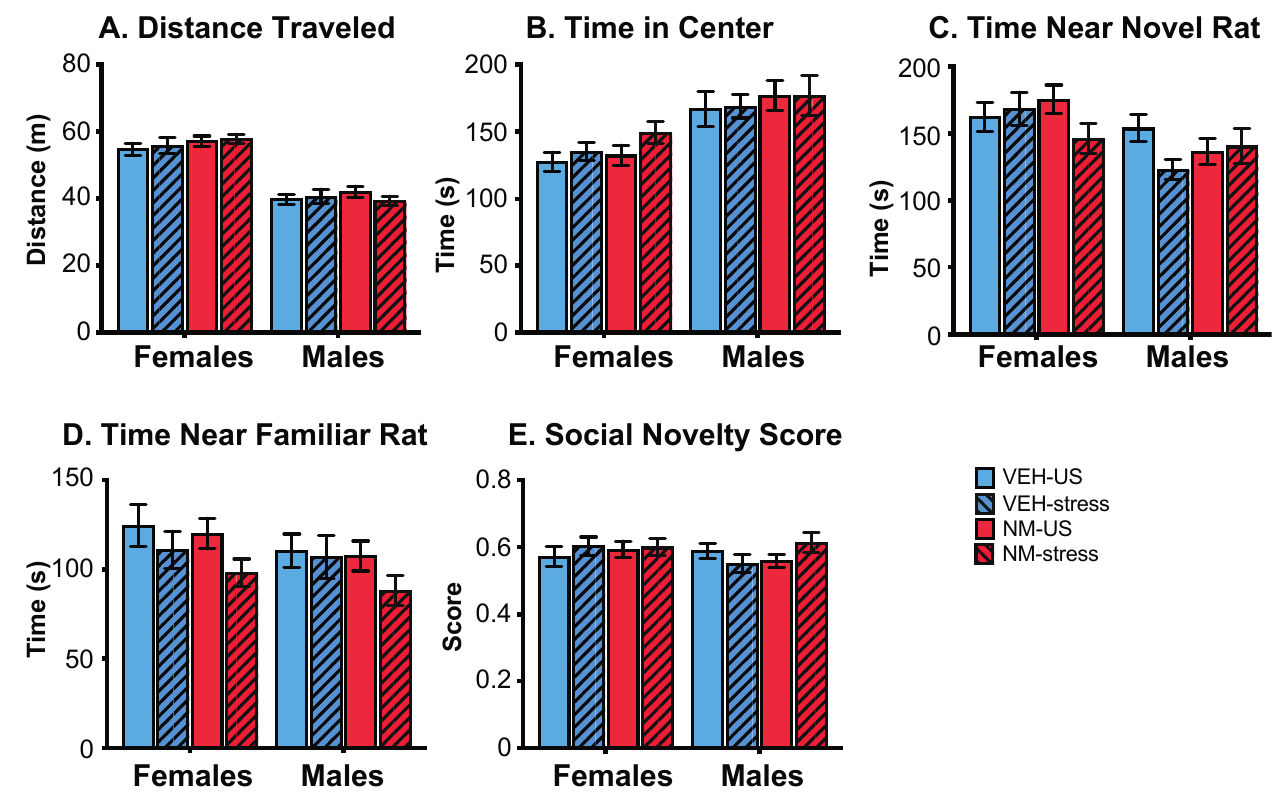
Figure 5. Effects of prenatal NeuroMix and/or stress in adolescence on behaviors in the Social Novelty test in which rats were offered a choice between a familiar and a novel conspecific. No significant effects were found on ( A ) distance traveled, ( B ) time in center, ( C ) time near the novel rat, ( D ) time near the familiar rat, and ( E ) social novelty score. Sample sizes are the same as in Figure 4. VEH = vehicle; NM = NeuroMix; US = unstressed.